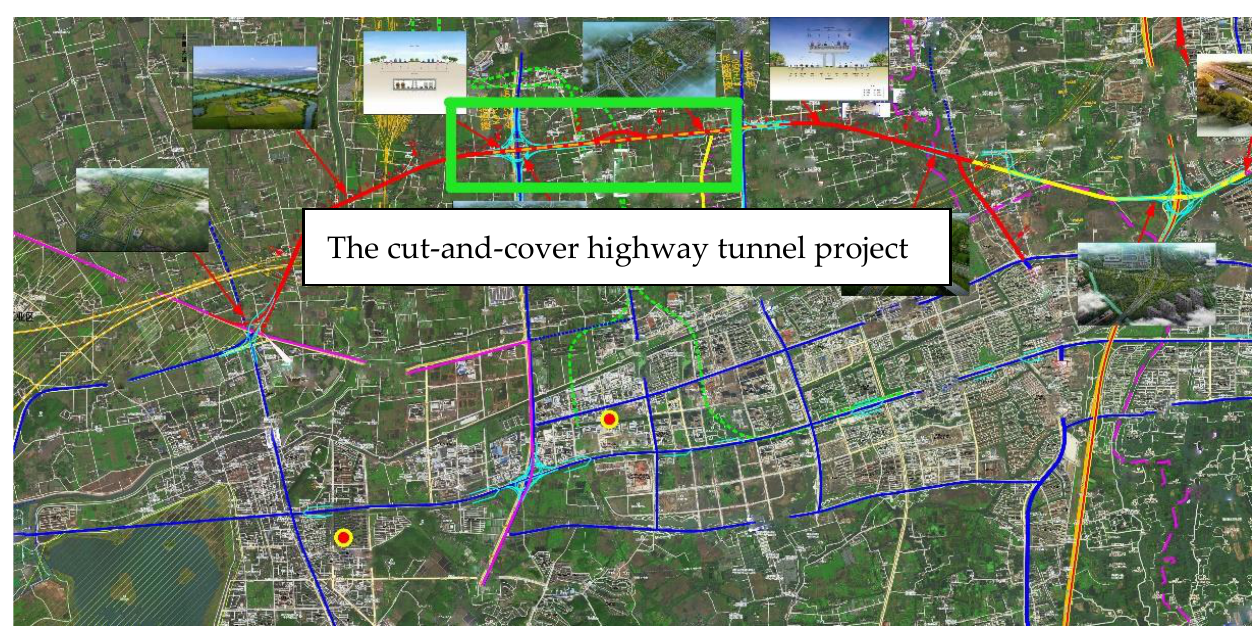
Figure 3. Location of the cut-and-cover highway tunnel project.